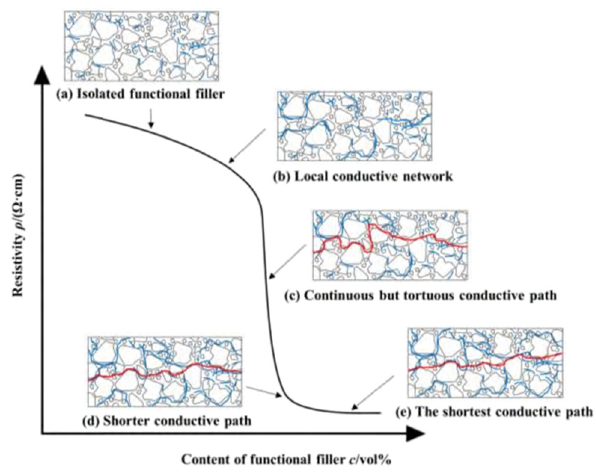
Figure 13: Schematic diagram of resistivity change with varied conductive phase doping [ 135 ] .